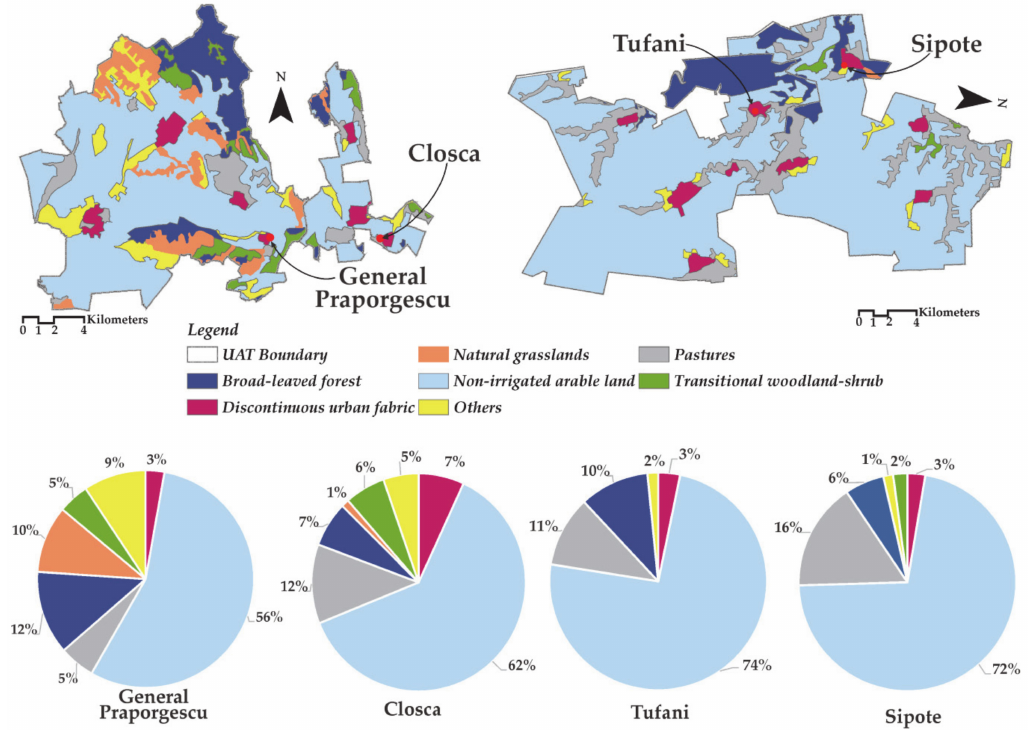
Figure 5. Land use categories in the vicinity of the karst springs from Northern and Southern